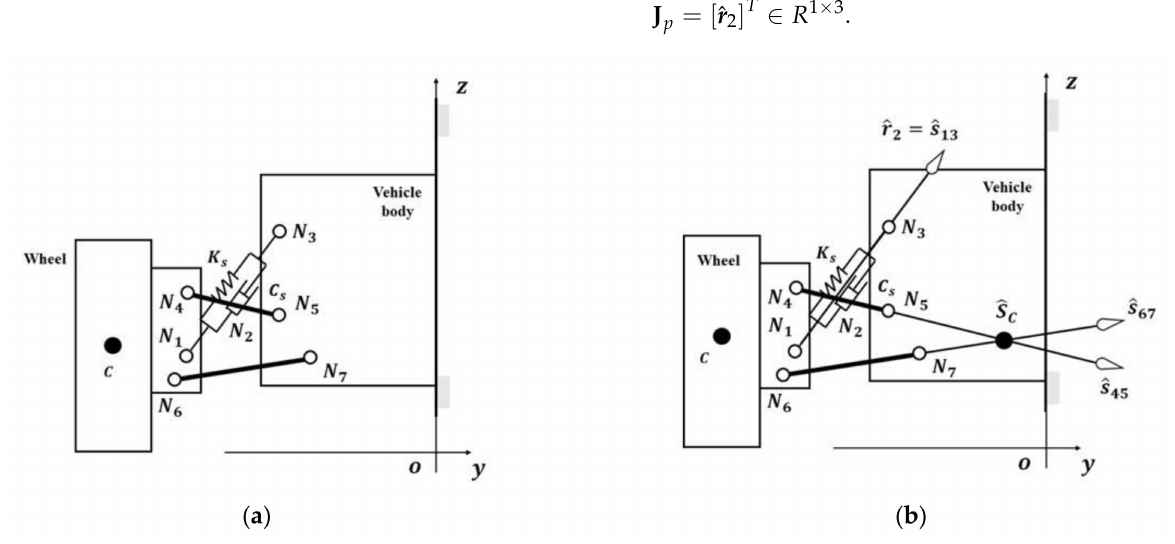
Figure 3. Planar double-wishbone suspension mechanism: ( a ) the schematic diagram; ( b ) the kinematic